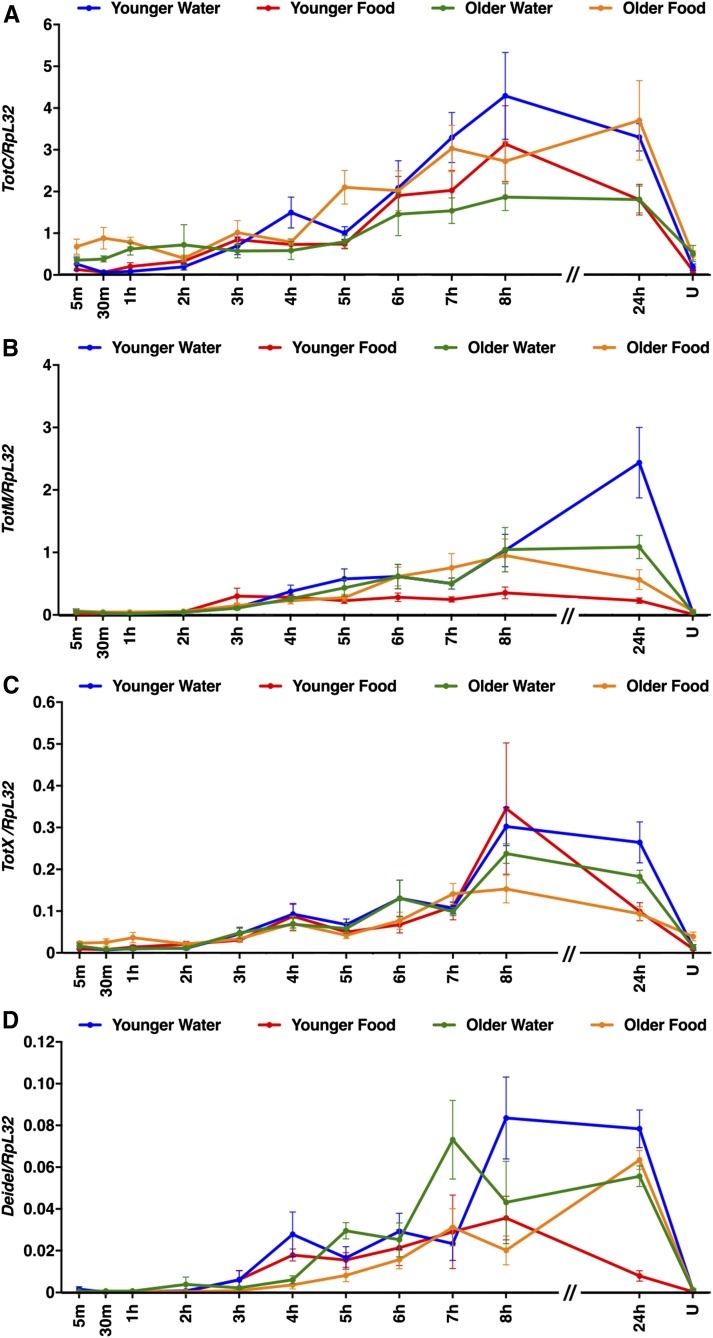
Age and diet affected expression of Tot family genes and Diedel following primary injuries. (A–D) Expression of the indicated genes relative to RpL32 following the standard injury protocol in w1118 flies under the indicated conditions. Note that y-axis scales are different among graphs and that the x-axis is not to scale between 8 and 24 hr. U indicates uninjured flies at the 24 hr time point. Each data point is the average and SEM of at least three biological replicates.